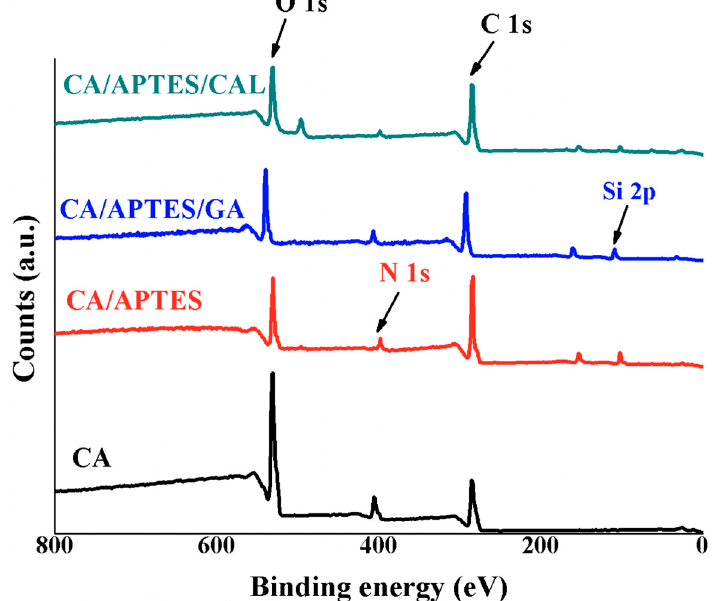
Figure 5. X-ray photoelectron spectroscopy (XPS) survey analysis of CA, CA/APTES, CA/APTES/GA, and CA/APTES/CAL membranes with marked interest peaks for C 1s, O 1s, Si 2p, and N 1s.